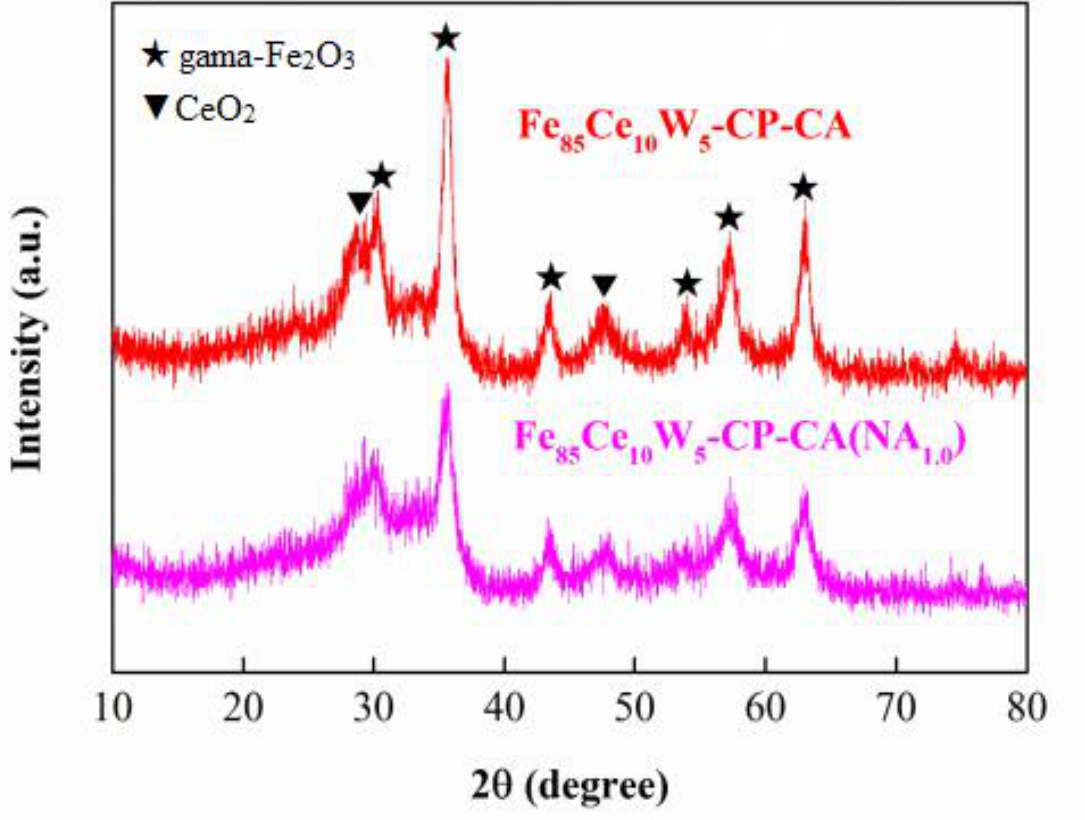
Figure 3. The x-ray diffraction (XRD) spectra of Fe 85 Ce 10 W 5 –CP–CA and Fe 85 Ce 10 W 5 –CP–CA(NA 1.0 ). ( ★ gama-Fe 2 O 3 25-1402, ▼ CeO 2 43-1002).